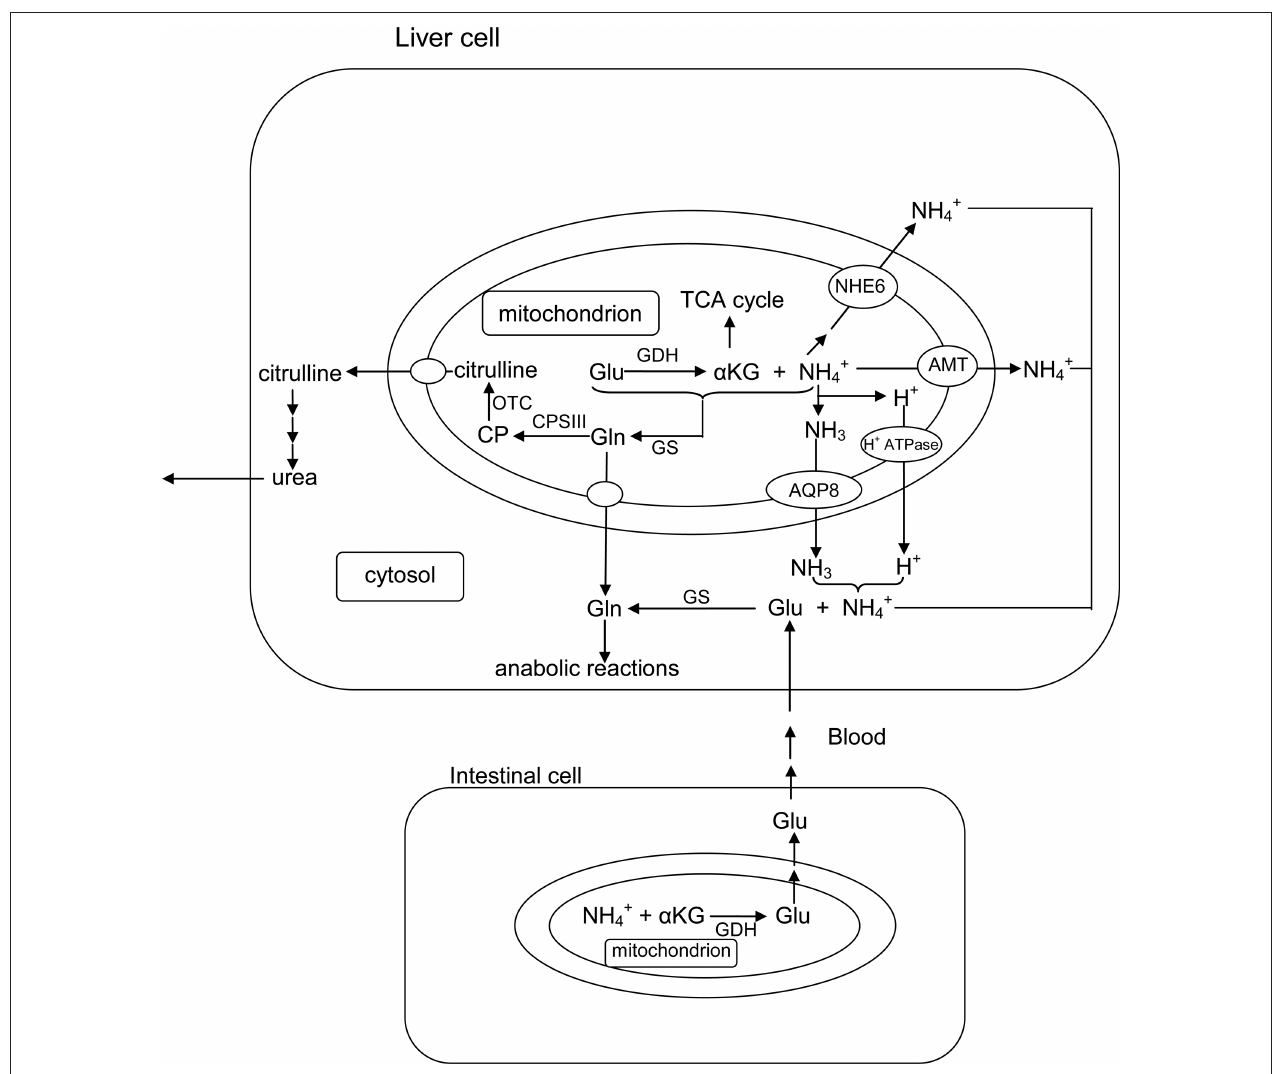
Figure 1 | The catabolism of excess amino acids through the process of transdeamination in liver cells releases ammonia and α -ketoglutarate ( α Kg) from glutamate (glu) catalyzed by glutamate dehydrogenase (gDH) in the mitochondria. To avoid the disruption of the H + gradient set up across the inner mitochondrial membrane by the electron transport system, ammonia produced within the mitochondrial matrix can exit the mitochondrion + transporter (AMT) or a Na + /H + exchanger (e.g., as NH 4 + through a putative NH 4 NHE6) in the liver cells of ammonotelic fishes. Alternately, ammonia can exit through an aquaporin channel (e.g., AQP8) as NH , accompanied with proton 3 (H + ) transport through an H + -ATPase. Ammonia can also be detoxified